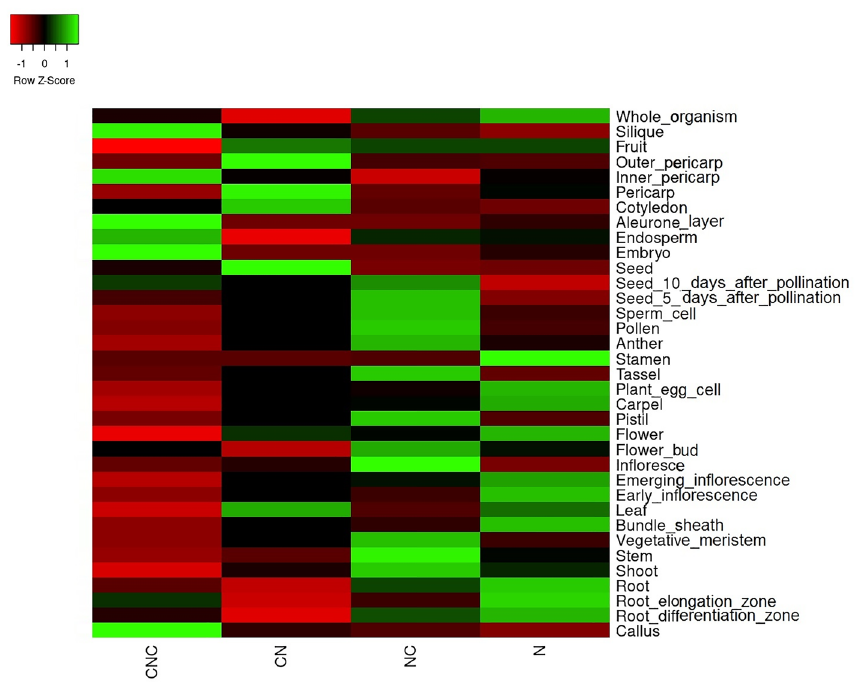
Figure 3. The average expression of the caleosin classes in each tissue. The caleosin classes have been named based on the order of non-cytoplasmic (N) and cytoplasmic (C)